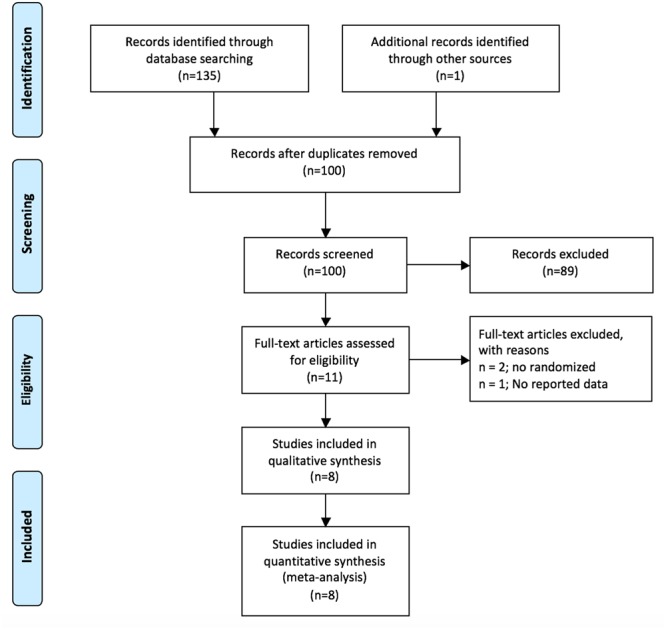
Flow diagram of excluded and included studies according to the PRISMA guide.